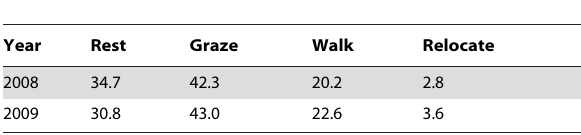
Table 9. Mean percentage of time spent engaging in four behaviours by buffalo during the 2008 and 2009 late flood seasons.